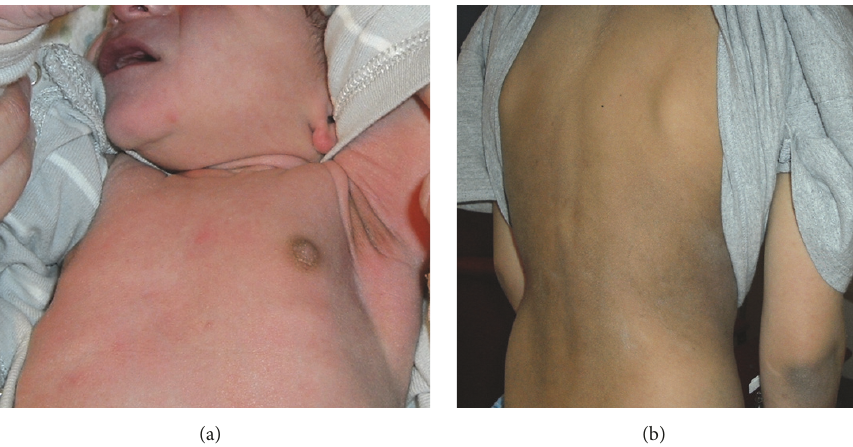
Figure 1: (a) Hyperpigmentation at nipples and axillar in a 10-day-old male infant with salt-wasting congenital adrenal hyperplasia due to 21-hydroxylase deficiency. (b) Hyperpigmentation in a 9-year-old boy with Addison's disease.